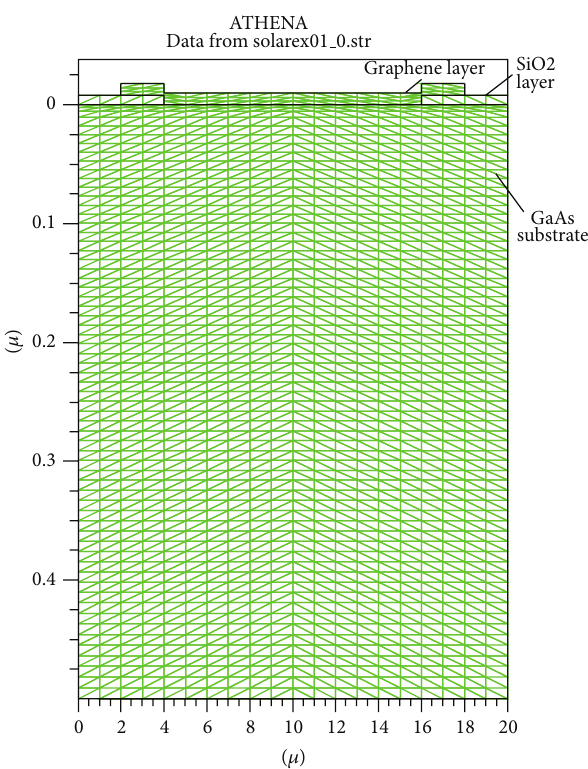
Figure 1: Cross section of the graphene GaAs solar cell.